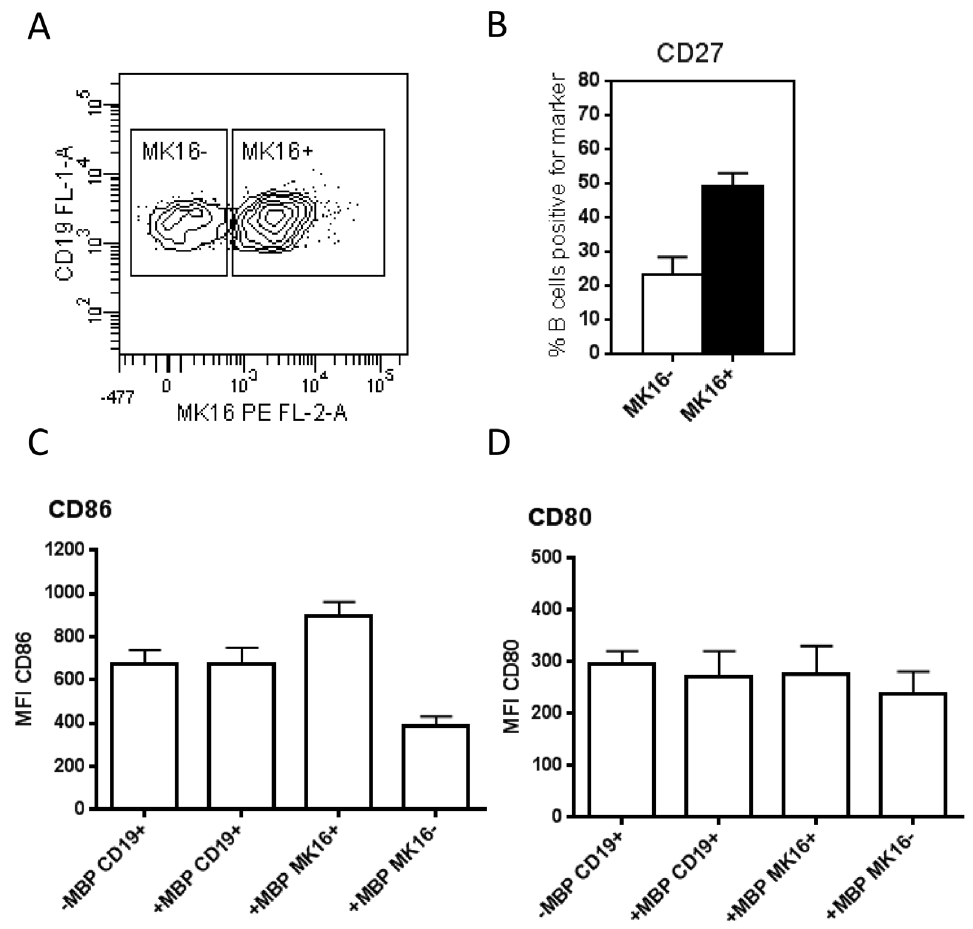
Figure 5. Phenotype of MBP85-99-presenting B cells. PBMCs from healthy HLA-DR15 + donors were incubated with MBP (30 m g/ml) in RPMI containing 30% (v/v) normal serum for 18 h. The presentation of MBP85-99 by CD19 + B cells was assessed using biotinylated MK16 and streptavidin- PE. A) Representative dot plot showing a subset of B cells that present MBP58-99 (MK16 + ) and a subset that do not (MK16 2 ). Expression of various surface markers was evaluated in these subsets. B) The percentages of MK16 + (black bar) or MK16 2 (white bar) B cells expressing CD27 are shown (N=4). B-cell expression of the co-stimulatory molecules C) CD86 and D) CD80 is shown as mean fluorescence intensity (MFI) values (N=5). 7-AAD was used to exclude dead cells. Data are shown as means and